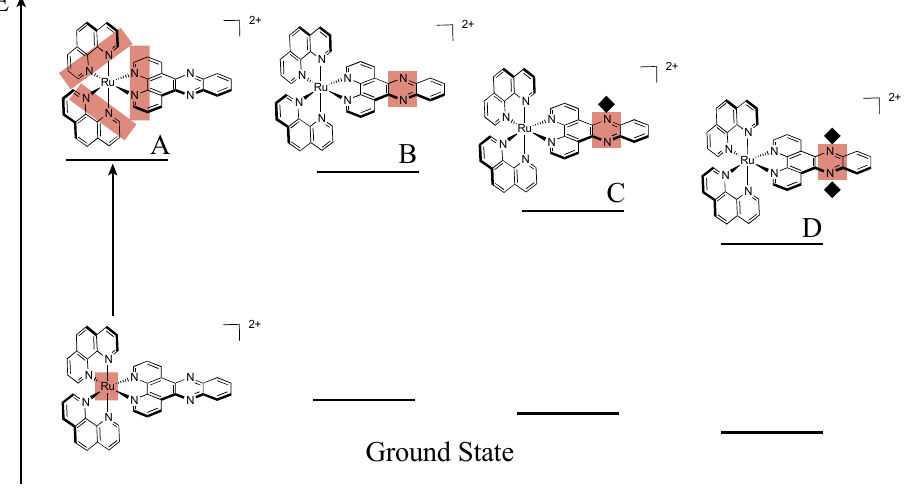
(DPPZ)] 2+ in polyol solvents 2